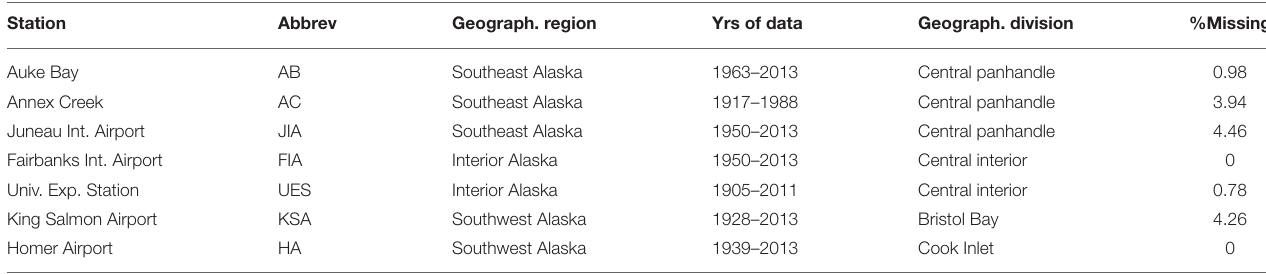
TABLE 1 | Locations of temperature measuring stations, their abbreviations, the geographical region each station represents, years of data included in the study for each station, the climate division each station belongs, and the % of months for which observations were missing.